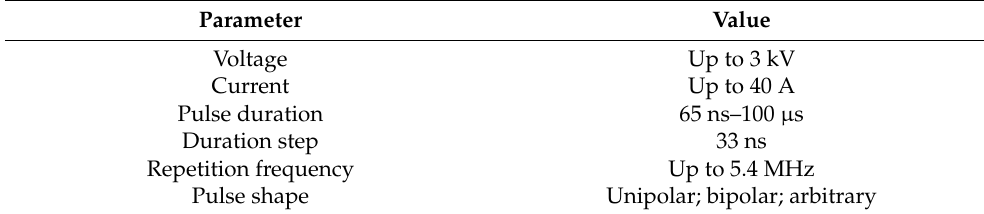
Table 1. The parameters of the developed